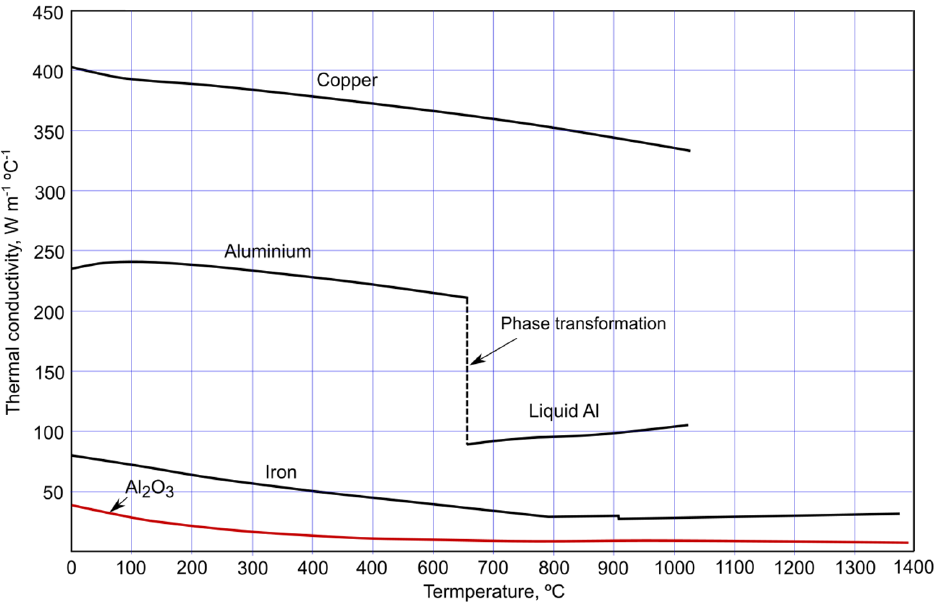
Figure 1. Thermal conductivity changes with temperature of different pure metals. Redrawn from [22].